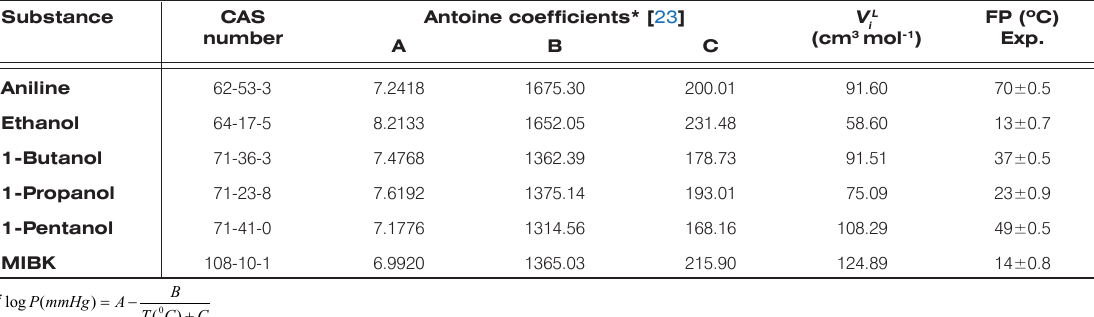
Table 1. Antoine coefficients, flash points and molecular volume for pure components.